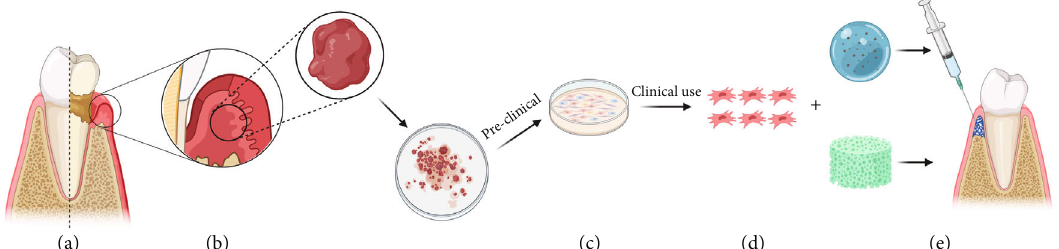
Figure 4: (a) Periodontitis is an in fl ammatory disease a ff ecting tooth-supporting tissues. Granulation tissue exists in the periodontal defects of patients with periodontitis and is usually discarded in traditional therapy. (b) Granulation tissue can be partially preserved during surgical periodontal therapy or minimally processed, acting as a reservoir of progenitor cells. (c) Heterogeneous cells derived from granulation tissue should be further researched preclinically prior to application in clinical practice. (d) Stem/progenitor cells isolated from granulation tissue might be a potential substitute source of stem cells for cell-based therapies in regenerative medicine and dentistry. (e) A combination of stem cells and di ff erent types of biomaterials might be the trend in future clinical